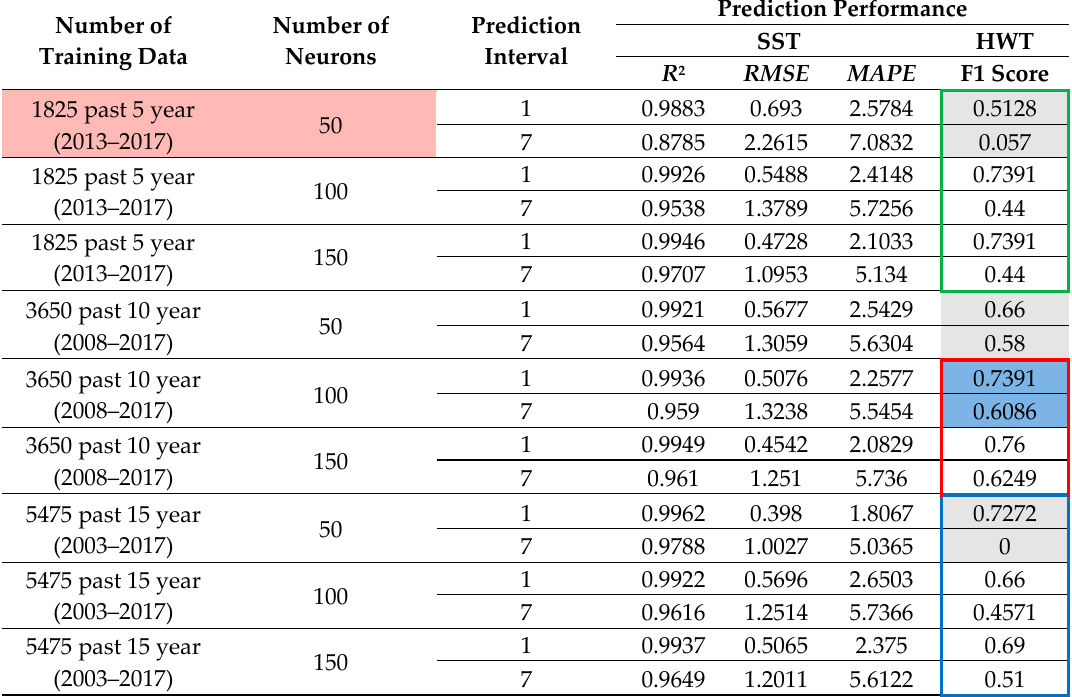
Table A1. Sensitivity of LSTM model to changes in the number of neurons and training data. Table A. Sensitivity of LSTM model to changes in the number of neurons and training